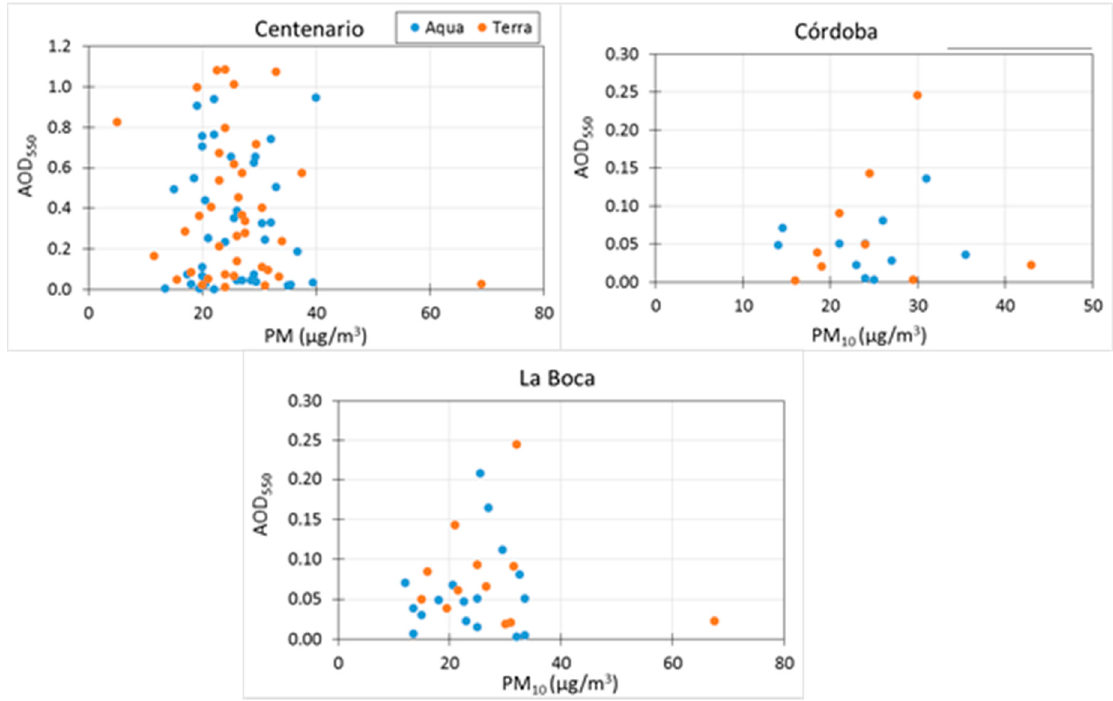
Figure 12. PM average ±60 min satellite overpass vs. AOD of the pixel corresponding to each PM station location (Centenario, Córdoba and La